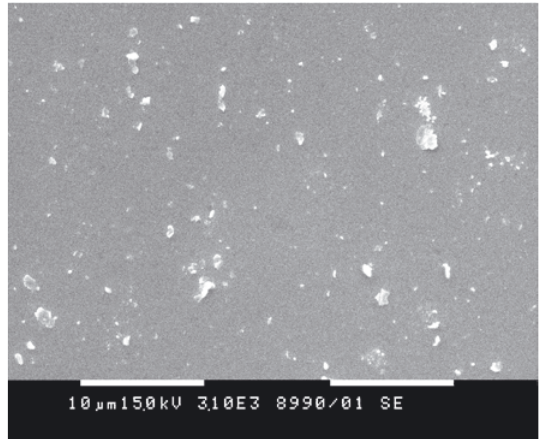
Figure 12. SEM of the G/S (25:75 wt.%) hybrid before immersion in 1.5 SBF